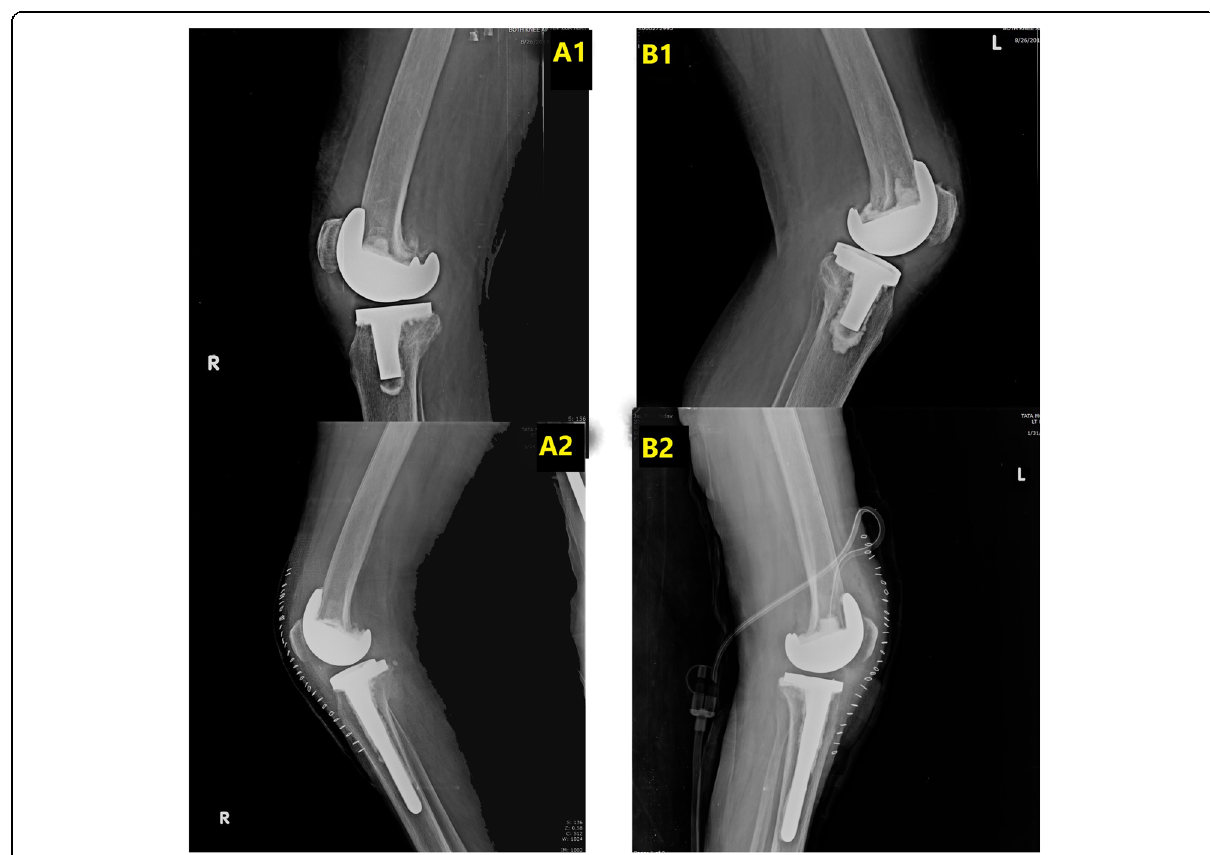
Fig. 4 A1 , A2 Postoperative results of first patient. B1 , B2 Postoperative results in second